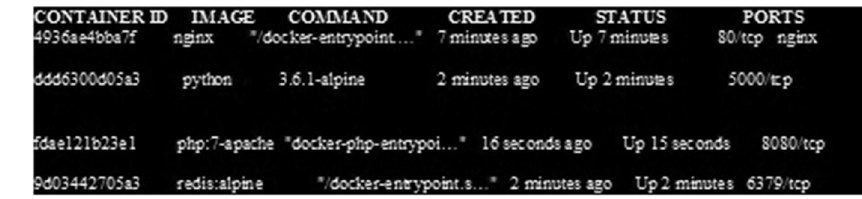
Fig. 3 Service Discovery for the